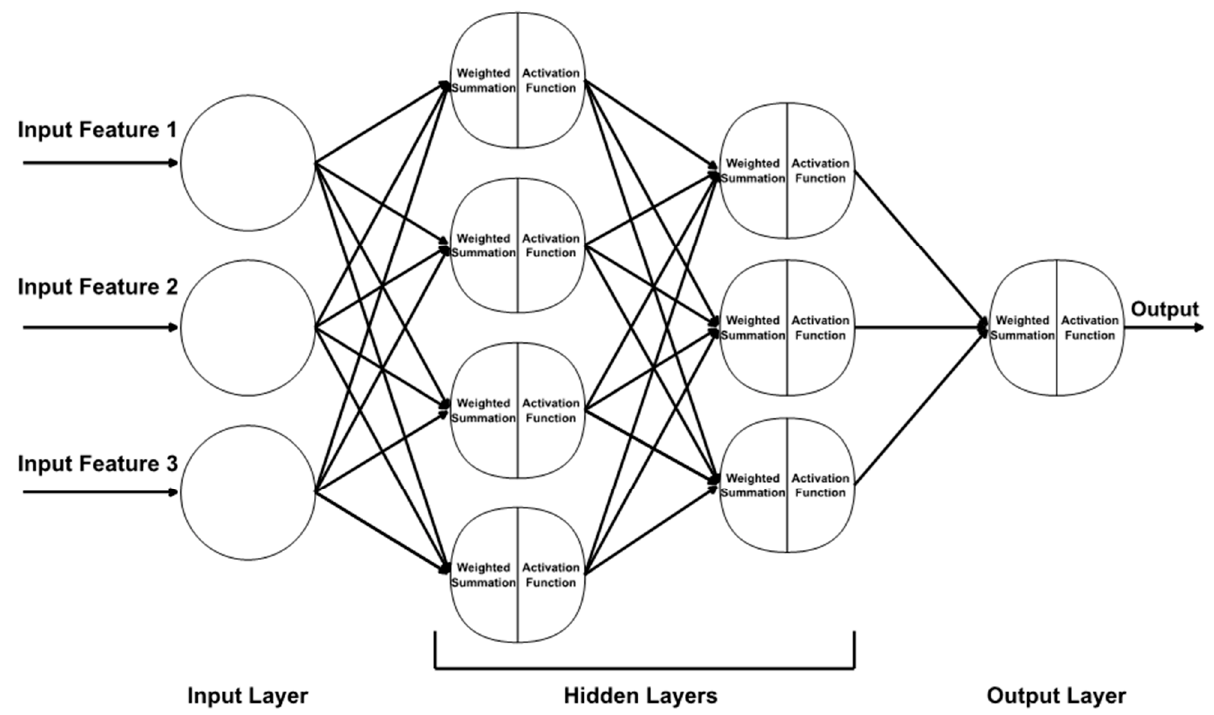
Figure A1. General structure of an artificial neural network.